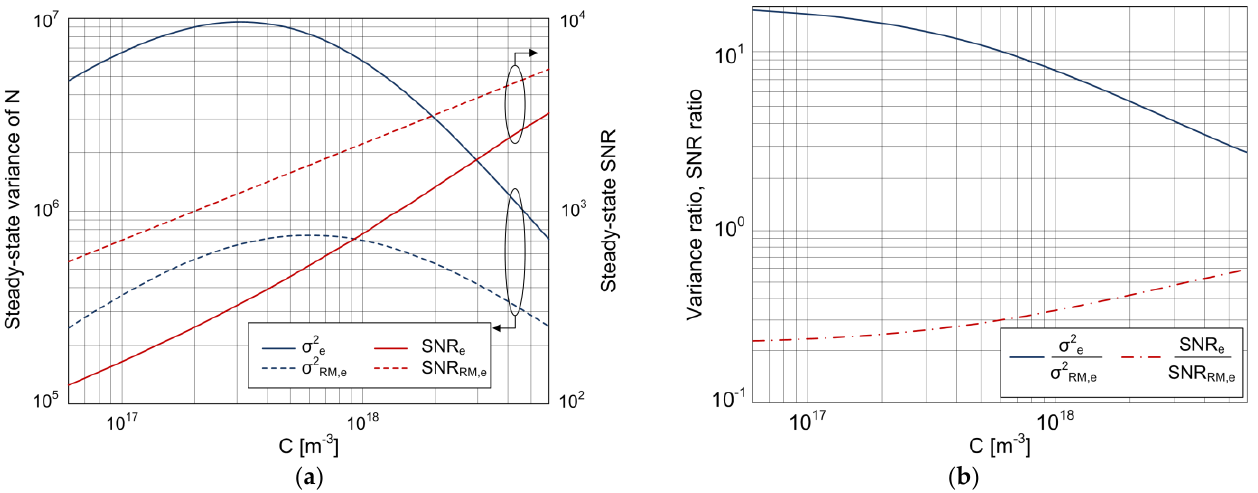
Figure 6. ( a ) Dependence of the variance of the number of adsorbed particles and sensor’s SNR ( A = 10 −9 m 2 ) in the steady state on the target substance concentration, according to the stochastic model that takes into account MT (solid lines), and the model that neglects it (dashed lines). ( b ) Ratios of steady-state variances ( σ 2 e / σ 2 RM,e ) and SNRs ( SNR e / SNR RM,e ) according to the two models, depending on the concentration.